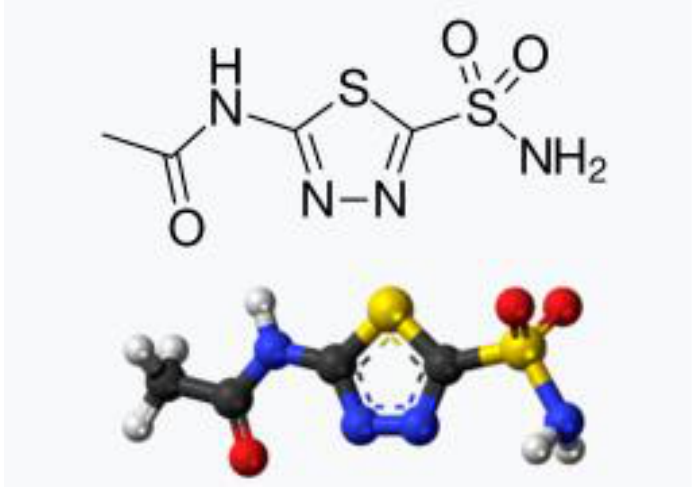
Figure 6. Scheme of In(III) ions electroreduction in chlorates(VII) including the mediating role of active complexes in the charge (electron) transfer.